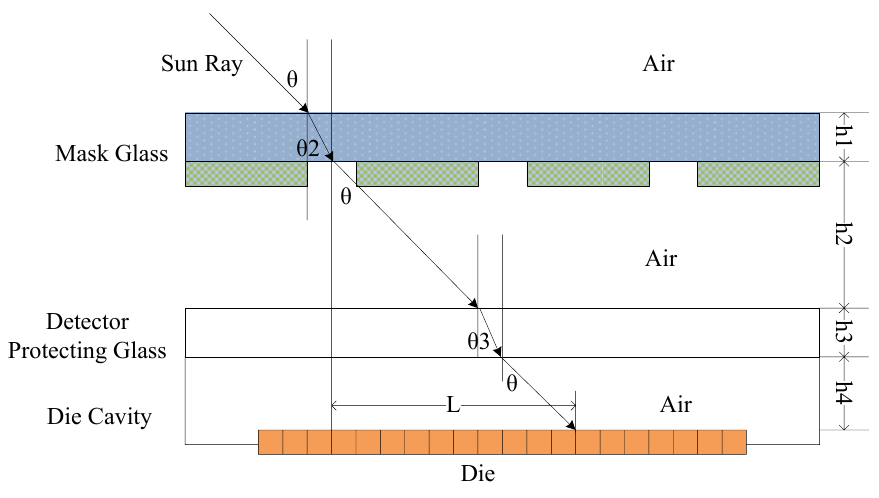
Figure 2. The optical refraction model of DSS.